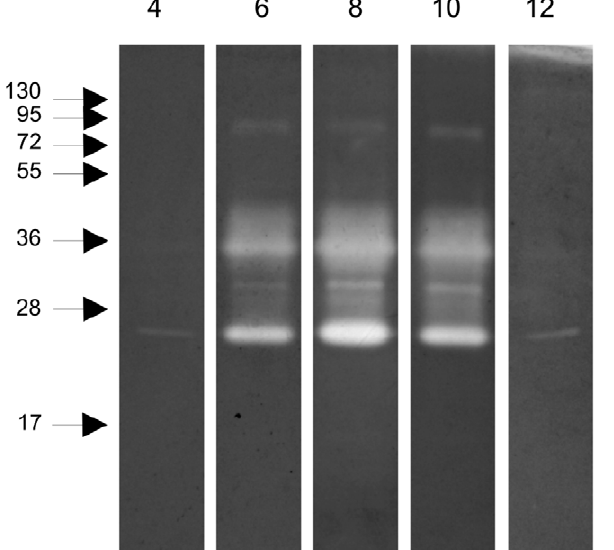
Figure 3. Zymography performed with gelatin co-polymerized gel, incubated in different pH defined buffers. 4 to 12 : pH of buffers. Samples corresponding to 1/50 of one insect midgut obtained at 12 h ABF were loaded in lanes. Molecular mass standard values (kDa) are indicated by numbers and arrows on the left side of the figure.